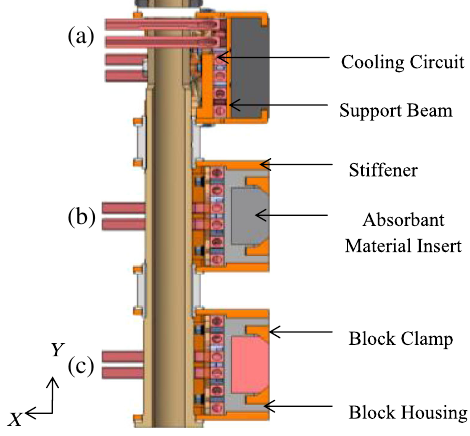
FIG. 2. Internal HRMT-23 jaw X - Y cross-sectional view for (a) TCSP, (b) TCSPM-M, and (c) TCSPM-C